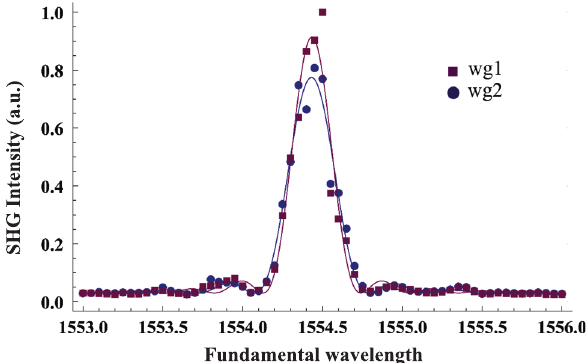
Fig. 2 SHG measurements: purple squares correspond to SHG process in wg1 and blue dots to SHG in wg2. Continuous lines are fi ts. It is clear that the two processes overlap. Error bars are smaller than the size of the